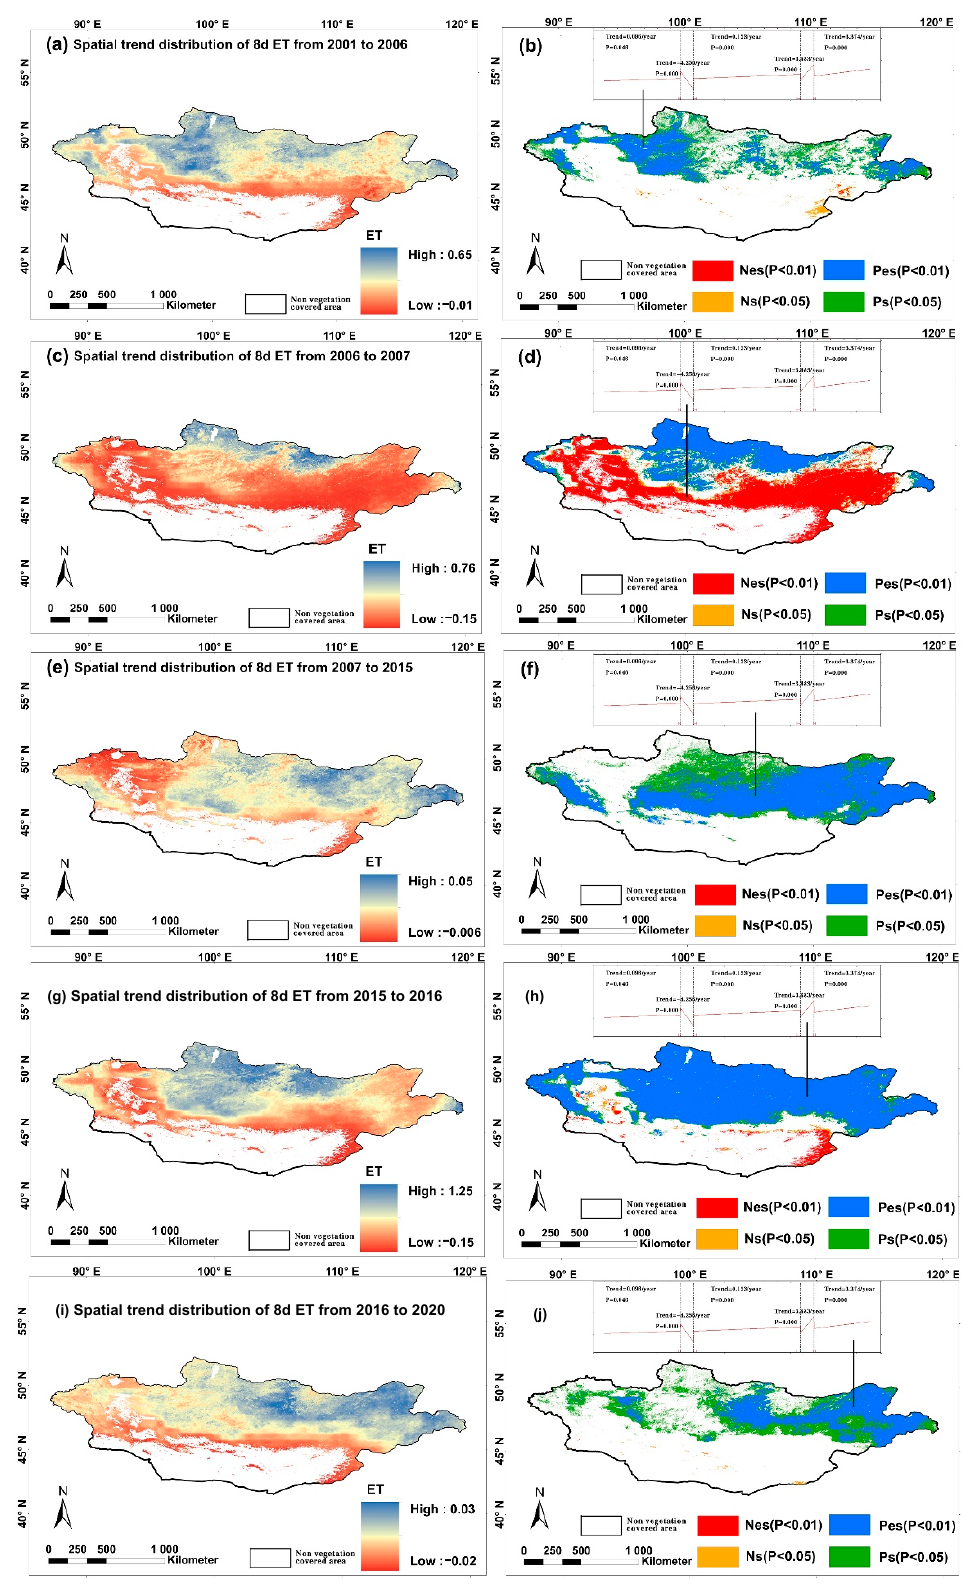
Figure 11. Spatial distribution and trend of the 8-day ET before and after different mutation points: ( a , b ) 2001 to 2006; ( c , d ) 2006 to 2007; ( e , f ) 2007 to 2015; ( g , h ) 2015 to 2016; ( i , j ) 2016 to 2020.